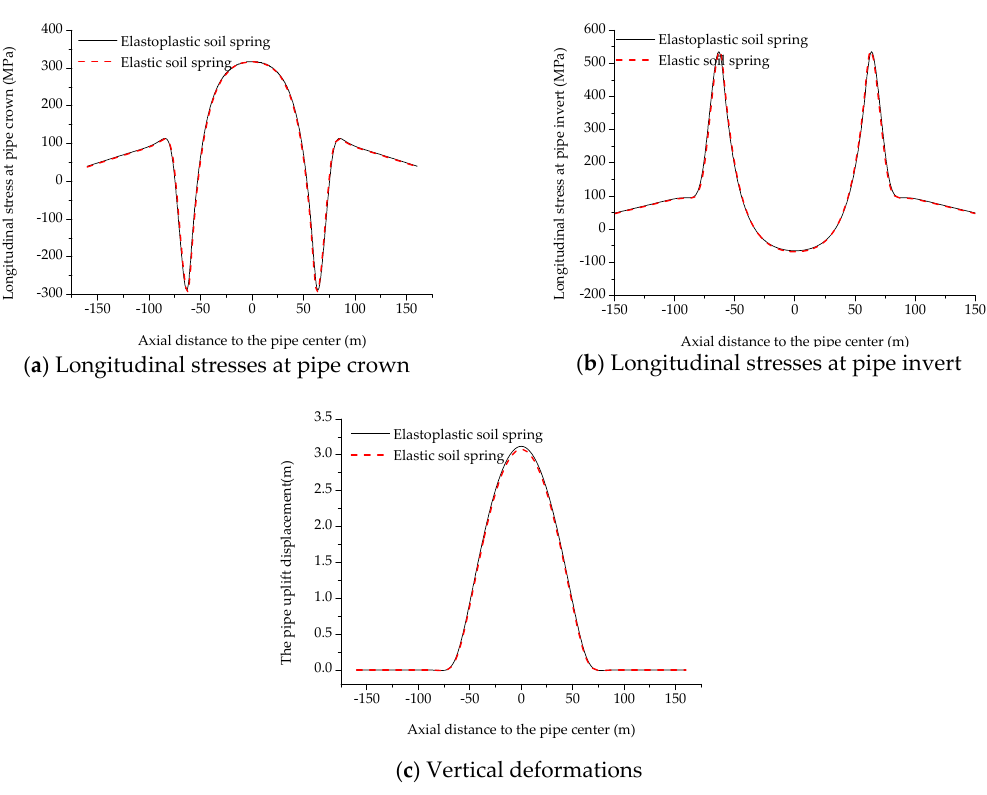
Figure 10. Results for a liquefaction zone length equal to 120 m.